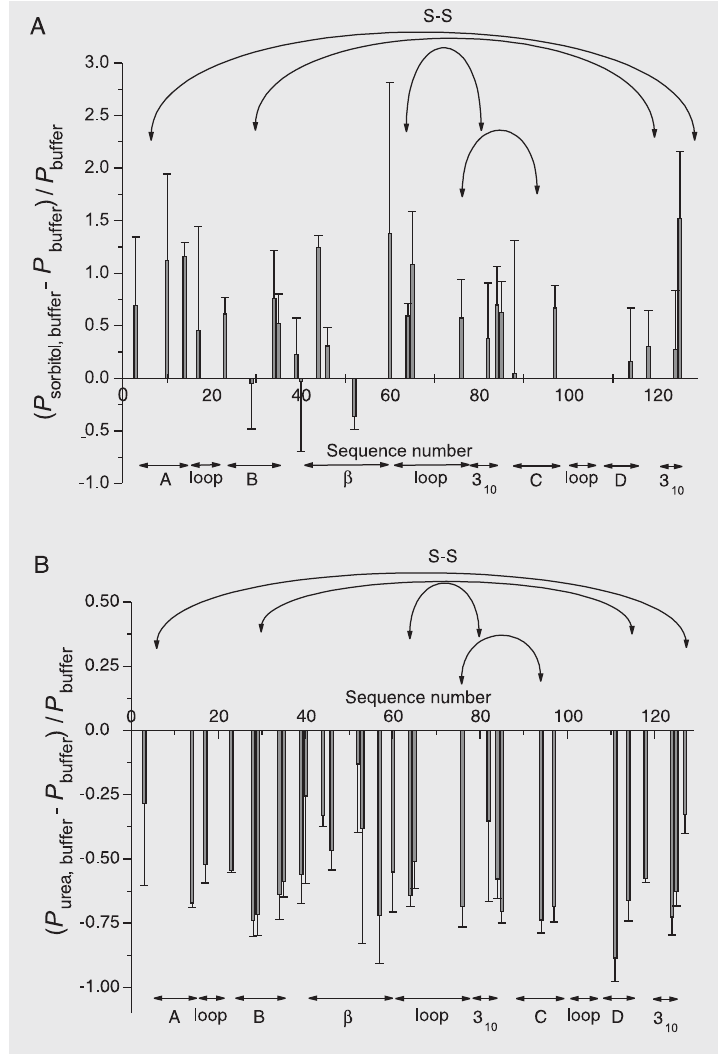
Figure 7. Relative changes in P -factors upon the addition of 500 mM sorbitol (A) and 2 M urea (B) for the pressure-assisted cold-denatured state. In both cases, no particular region within the protein can be identified which shows a significant diverse change of P -factors. Obviously, both co-solvents influence the structure of hen egg white lyso- zyme in the pressure-assisted cold-denatured state uniformly and cooperatively. For other explanations, see legend to Figure